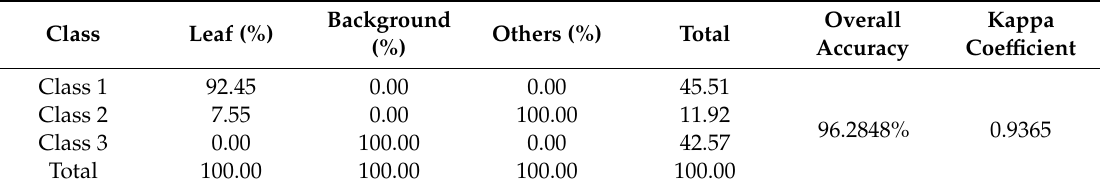
Table 6. Classification accuracy evaluation of original normal image.